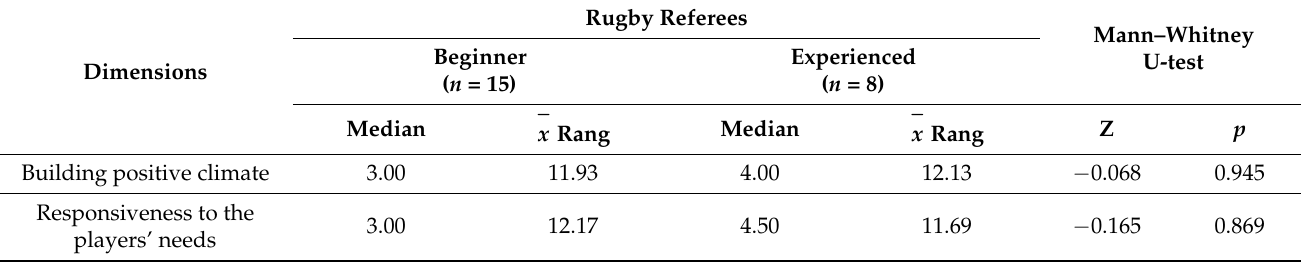
Table 5. Differences in the assessment of the quality of referee–players’ interactions in all dimensions between experienced and inexperienced referees ( n = 23).